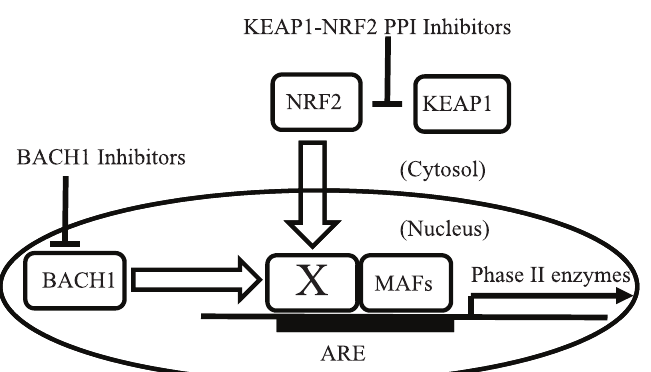
Figure 4. Two types of PPI inhibitors can activate NRF2. NRF2-KEAP1 PPI inhibitors directly inhibit binding of NRF2 and KEAP1 proteins and result in NRF2 release, translocation into the nucleus, and activation of phase II gene transcription 59,60 . Under physiological conditions, BACH1 constitutively inhibits NRF2-mediated transcriptional activity 68–71 . BACH1 inhibitors bind to BACH1 68–71 . Thus, BACH1 inhibitors can activate transcription of NRF2-dependent phase II genes 74 . In this figure, the “X” designates a partner of sMAFs 72,73 . X and sMAFs can form homo- or hetero-dimers and bind to ARE elements 72,73 . When “X” is a sMAF or BACH1, phase II enzymes are not induced; in contrast, when “X” is NRF2, phase II enzymes are induced 72,73 . ARE, anti-oxidant-response element; BACH1, BTB and CNC homology 1; KEAP1, Kelch-like ECH-associated protein 1; NRF2, nuclear factor erythroid 2-related factor 2; PPI, protein-protein interaction; sMAF, small musculoaponeurotic fibrosarcoma